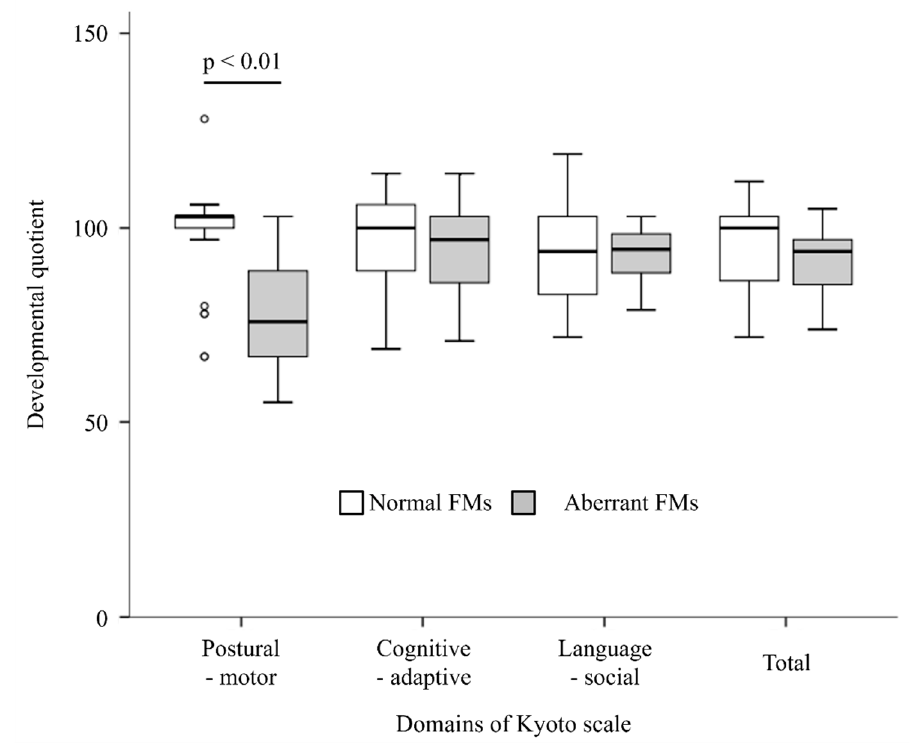
Figure 2. The DQ values at 3 years of age for the normal and aberrant groups.